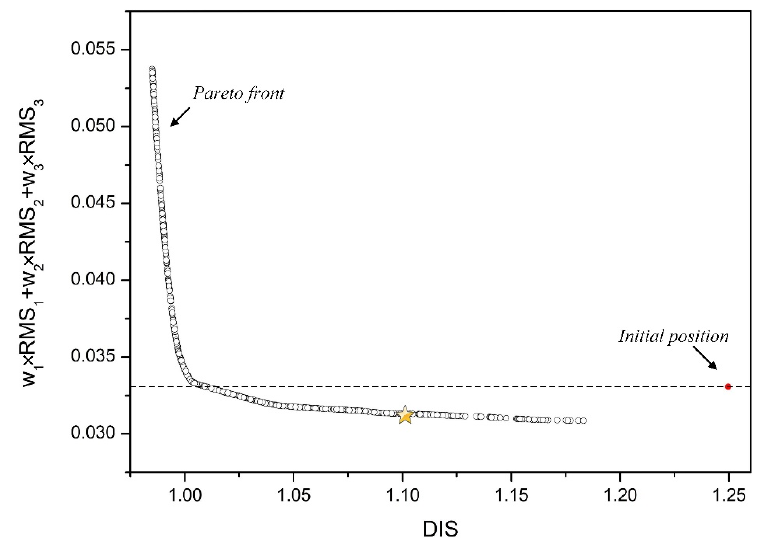
Figure 7. Comparison of the Pareto solution set and its initial state.